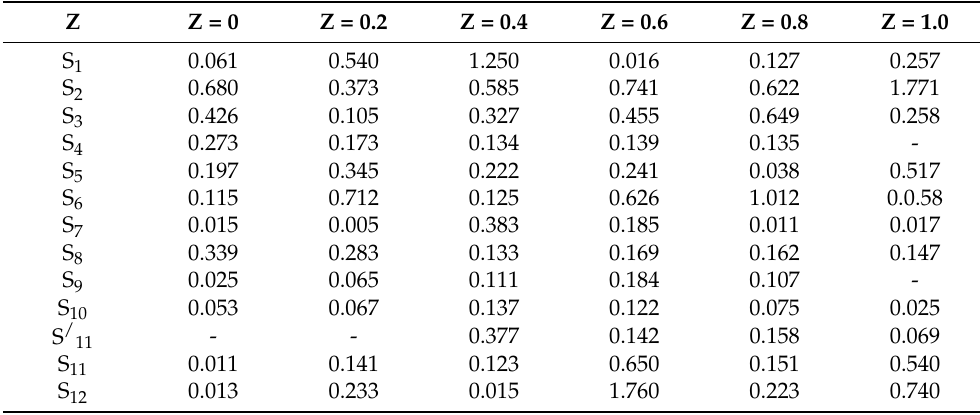
Table 3. Refined experimental parameters of strength S TO of transverse optical phonon modes